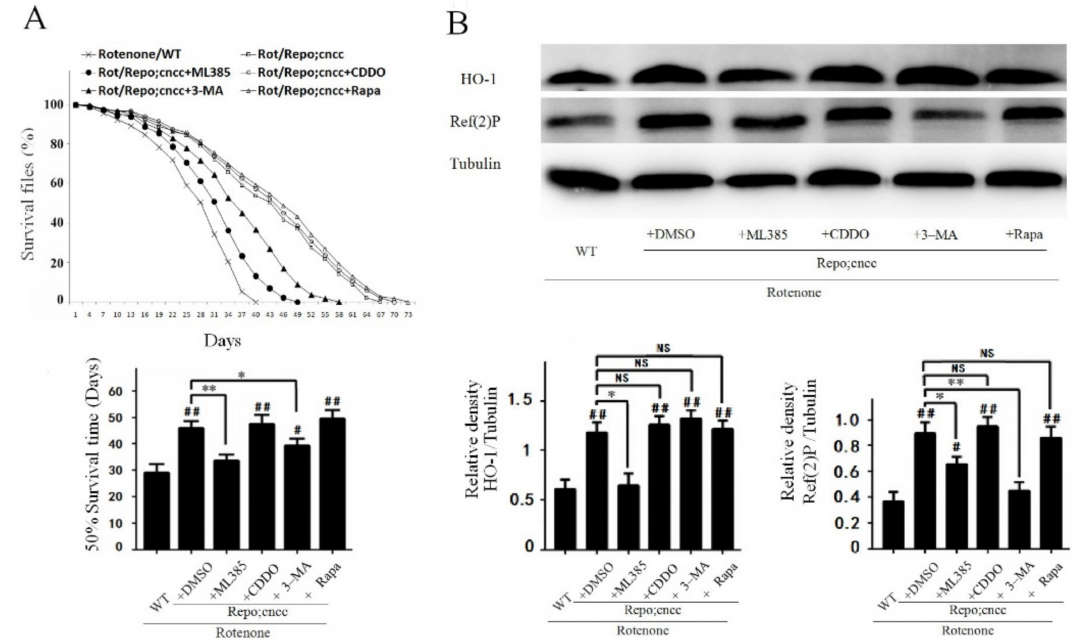
Figure 5. Activation of the Nrf2 signaling pathway enhanced autophagy in flies. ( A ) The graph shows the lifetime survival curve, the Log-rank test, and half survival time used to analyze the difference between groups ( # , compared with the rotenone/WT group). Nrf2 overexpression in glial cells effectively prolonged survival time in the Rot/Repo;cncc + DMSO group compared with the rotenone/WT group ( ## p < 0.01). The Nrf2 inhibitor ML385 significantly reduced the prolonged survival time in the Rot/Repo;cncc + ML385 group compared with the Rot/Repo;cncc + DMSO group (** p < 0.01). The autophagy inhibitor 3-MA partly reduced the prolonged survival time of the Rot/Repo;cncc + 3-MA group (* p < 0.05). The Nrf2 inducer CDDO-Me and autophagy inducer rapamycin did not significantly affect the survival time of the Rot/Repo;cncc + DMSO group. ( B ) Western blot analysis of antioxidant and autophagy proteins in fly brain. Nrf2 overexpression in glial cells significantly increased HO-1 and Ref(2)P proteins in the rotenone/Repo;cncc group compared with the rotenone/WT group ( ## p < 0.01). The Nrf2 inhibitor ML385 effectively decreased HO-1 and Ref(2)P levels in the rotenone/Repo;cncc + ML385 group compared with the rotenone/Repo;cncc + DMSO group (* p < 0.05). The autophagy inhibitor 3-MA effectively decreased Ref(2)P protein but not HO-1 protein, while the Nrf2 inducer CDDO-Me and autophagy inducer rapamycin did not significantly affect the expression of HO-1 and Ref(2)P in the rotenone/Repo;cncc + DMSO